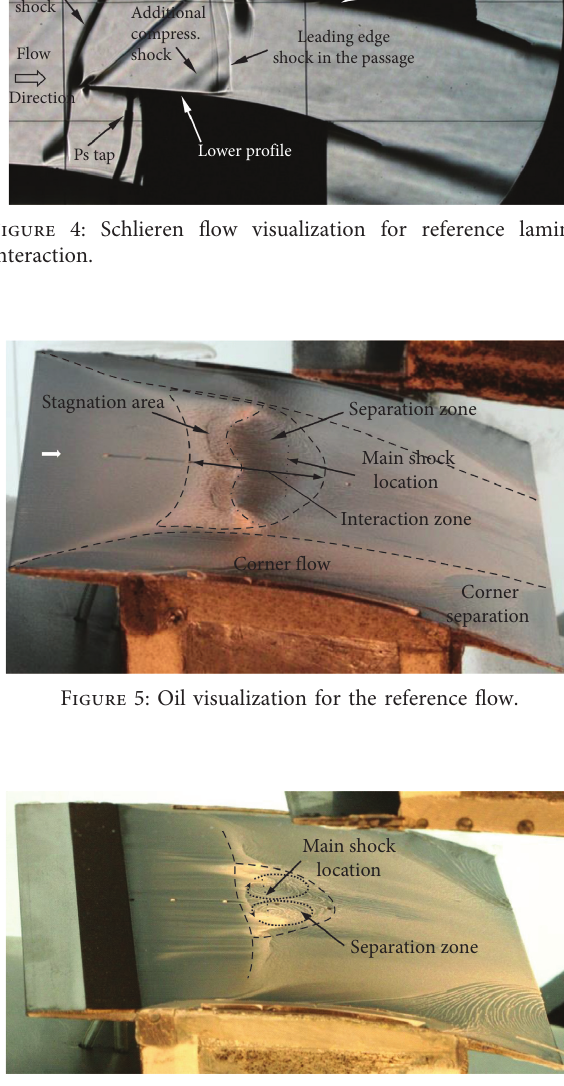
Figure 6: Oil visualization for the flow with roughness at X / C � 0.11 and Ra � 10 μ m.